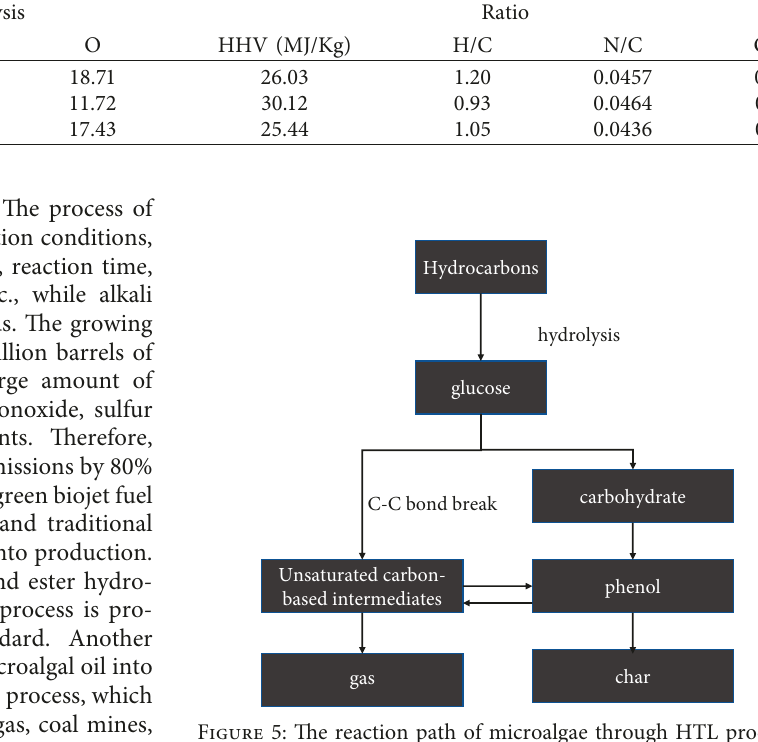
Table 3: The elemental compositions of biocrude oil and solid residue. Element Samples